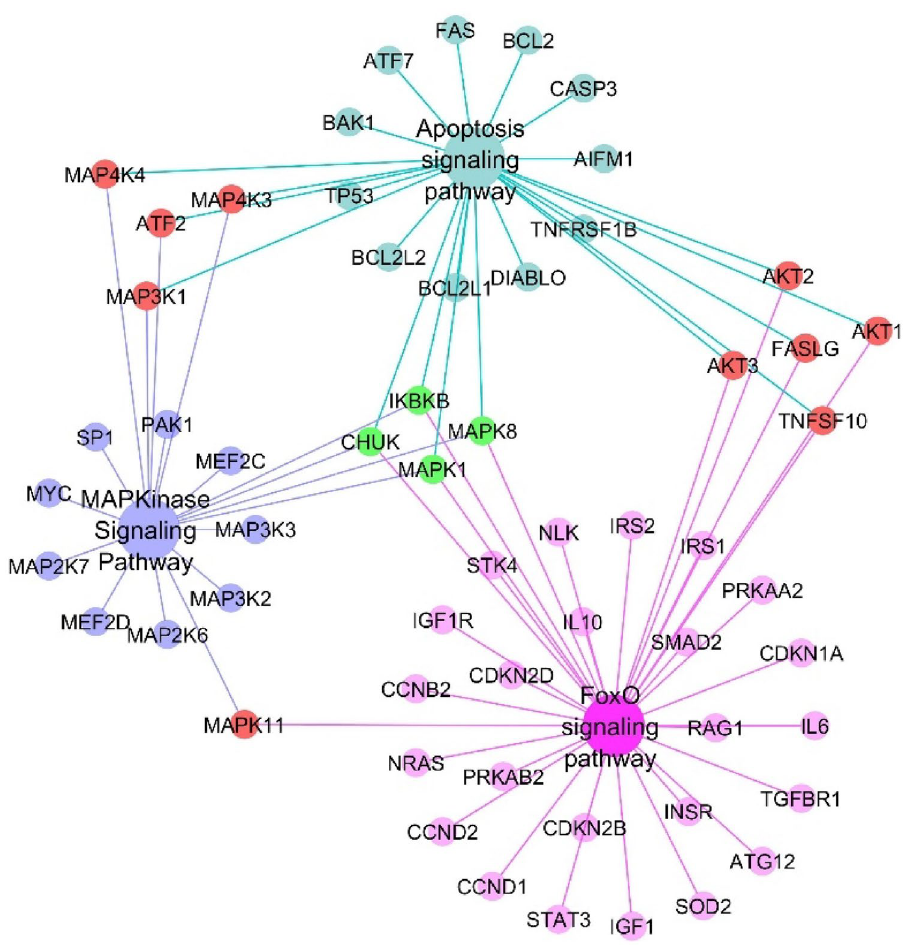
Figure 2. Multiple overlapping pathways identified using Enrichr analysis. Edges are colored based on their pathway of origin. Nodes colored in red and green are shared between 2 and 3 pathways,